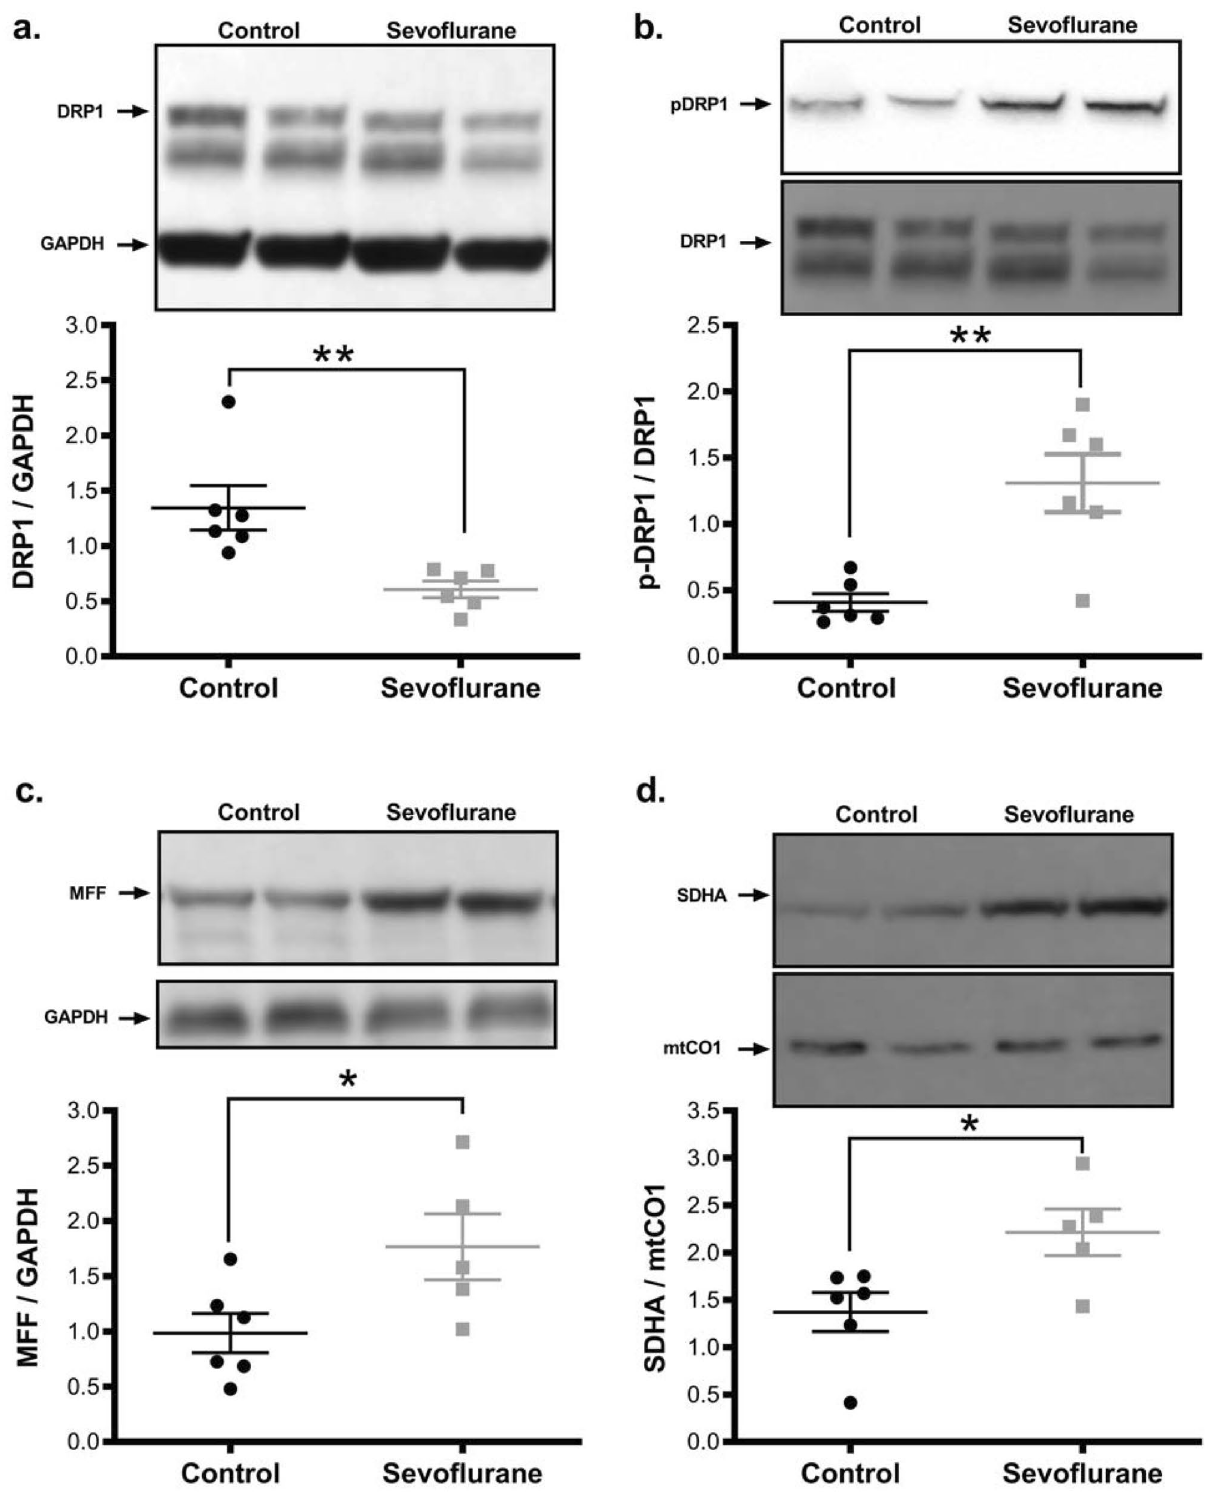
Figure 2. Sevoflurane exposure at P7 promotes mitochondrial fission and induces mitonuclear protein imbalance in the cortical tissue of adult rats. Sevoflurane exposure reduced the total level of the pro-fission GTPase DRP1 ( a ), but dramatically increased the level of the activated, phosphorylated form (pSer616-DRP1) ( b ). Similarly, the pro-fission DRP1 adapter MFF was elevated with sevoflurane exposure ( c ). Sevoflurane altered mitochondrial homeostasis, with an increase in nuclear-encoded protein components of the electron transport chain (Succinate Dehydrogenase Complex A-SDHA) relative to the mitochondrial-encoded components (Mitochondrial Cytochrome C Oxidase 1-mtCO1), adversely altering the mitonuclear protein balance (lower proportion of mitochondrial-encoded proteins) 27 . ( d ). Values represent means ± SEM, with 6 animals in each group. Statistical significance between groups indicated with (*) for p -value < 0.05, and (**) for p- value <